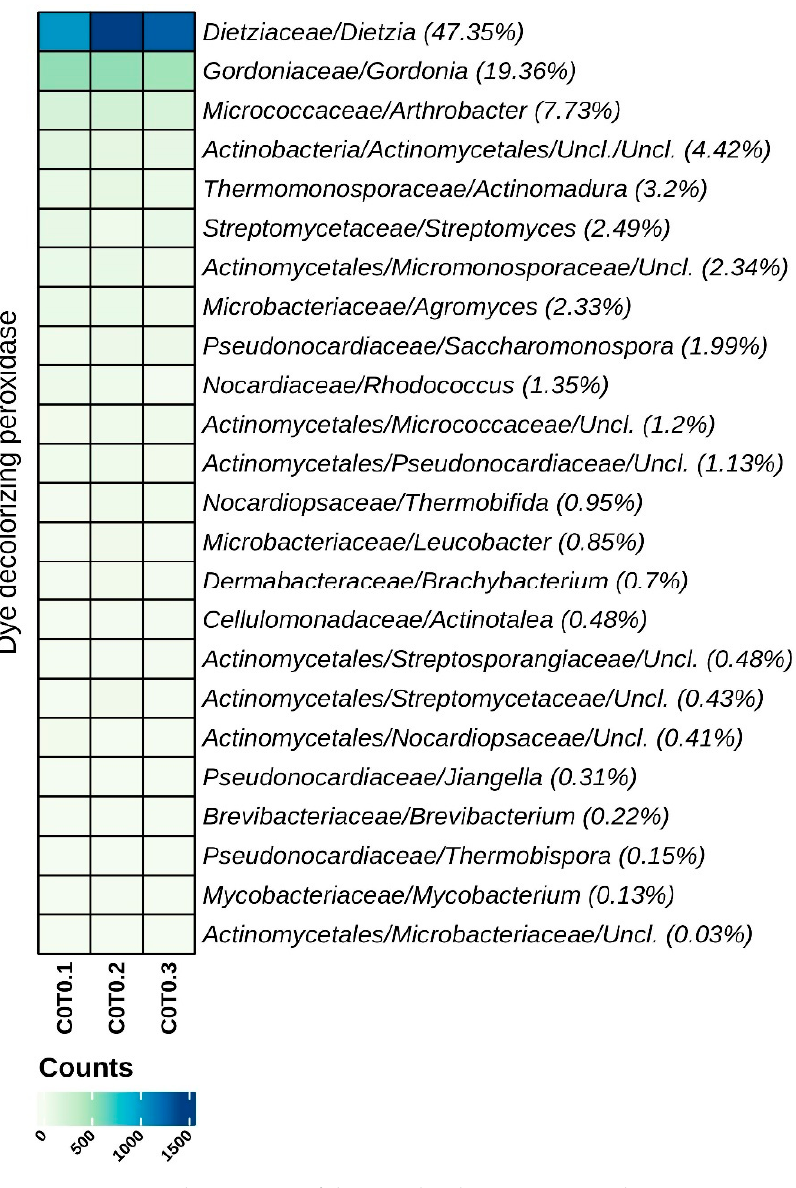
Figure 2. Functional Heatmaps of the Dye decolourising peroxidase enzyme contribution by identified ASVs aggregated at the Genus level, as inferred by PICRUSt2 in the three biological replicates. On rows, the nearest identified taxonomic level for each contributing ASV is reported, followed by its relative percentage contribution to the functional feature. Hierarchical clustering of columns was performed by Pearson correlation, based on Euclidean distance.